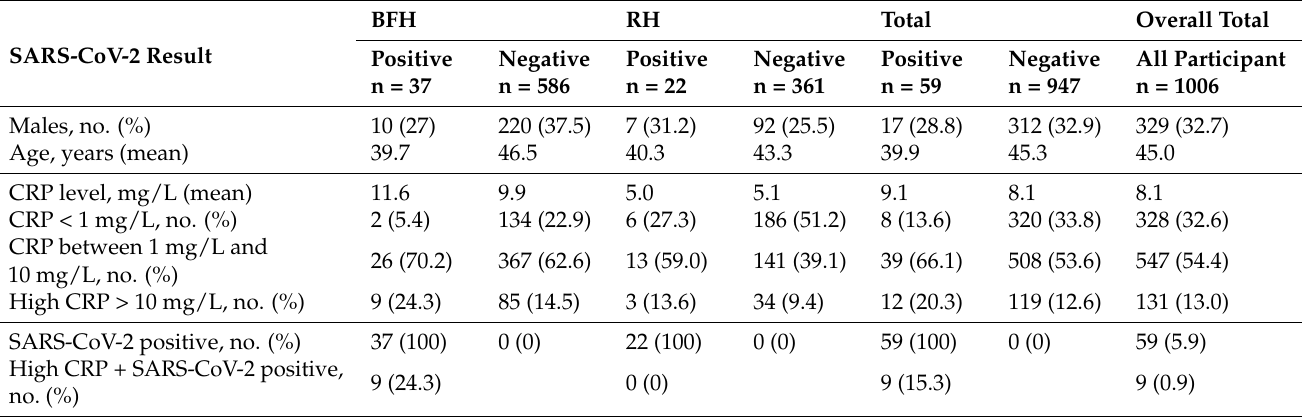
Table 1. Participant characteristics at baseline stratified according to subsequent SARS-CoV-2 test